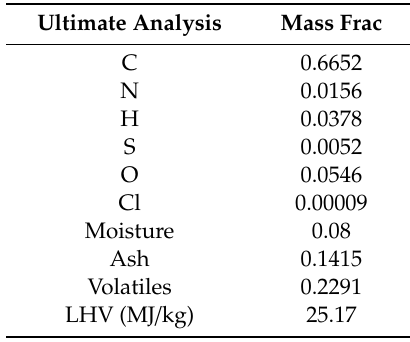
Table A5. Douglas Premium coal